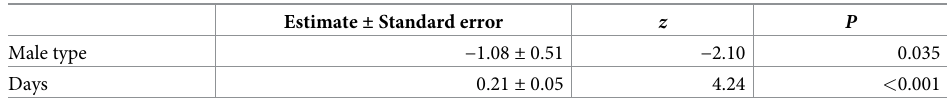
Table 2. Results of the generalized linear mixed model in laparotomy